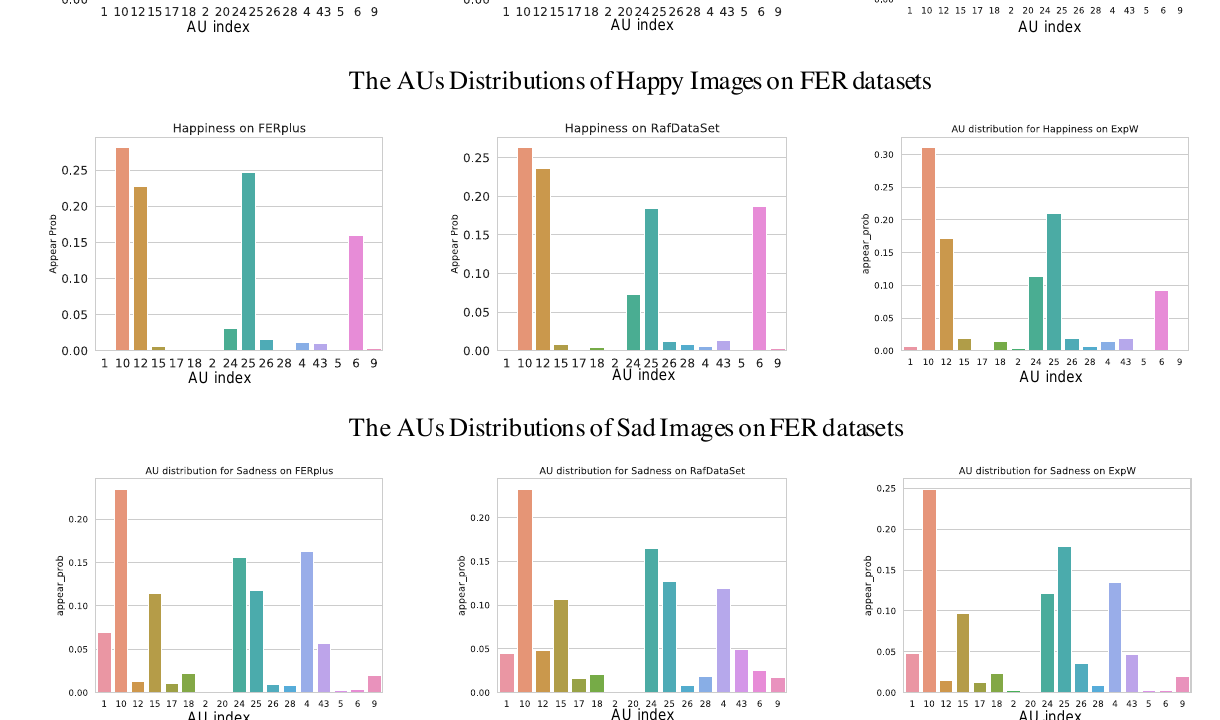
Figure 3. The distributions of AUs in different FER datasets. It can be seen that the AU distributions of a certain class in different datasets are almost